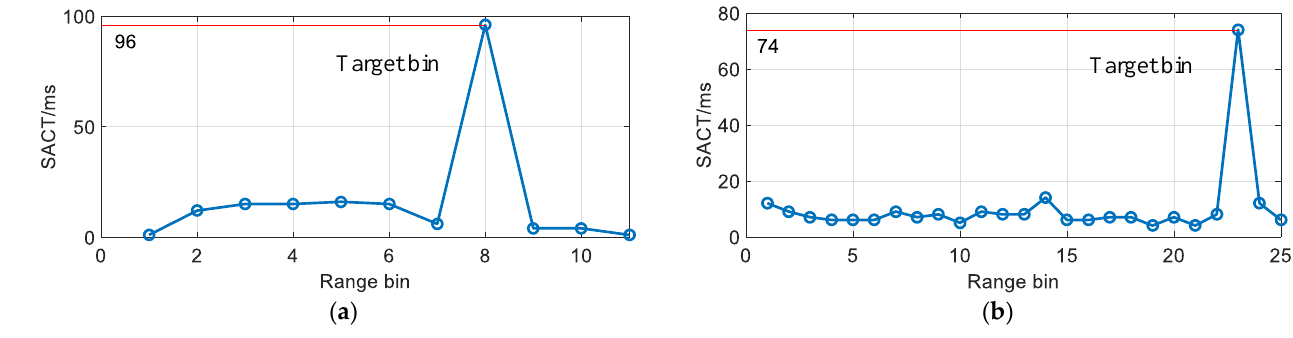
Figure 3. Diagram of the SACT. ( a ) SACT of IPIX-#1. ( b ) SACT of IPIX-#11. Simultaneously, the sea clutter at adjacent bins shows a certain correlation [25], while it is not correlated with the target echoes in the space domain. The space correlation coefficient r j of the time series y ( n ) of the j th range bin can be defined as: